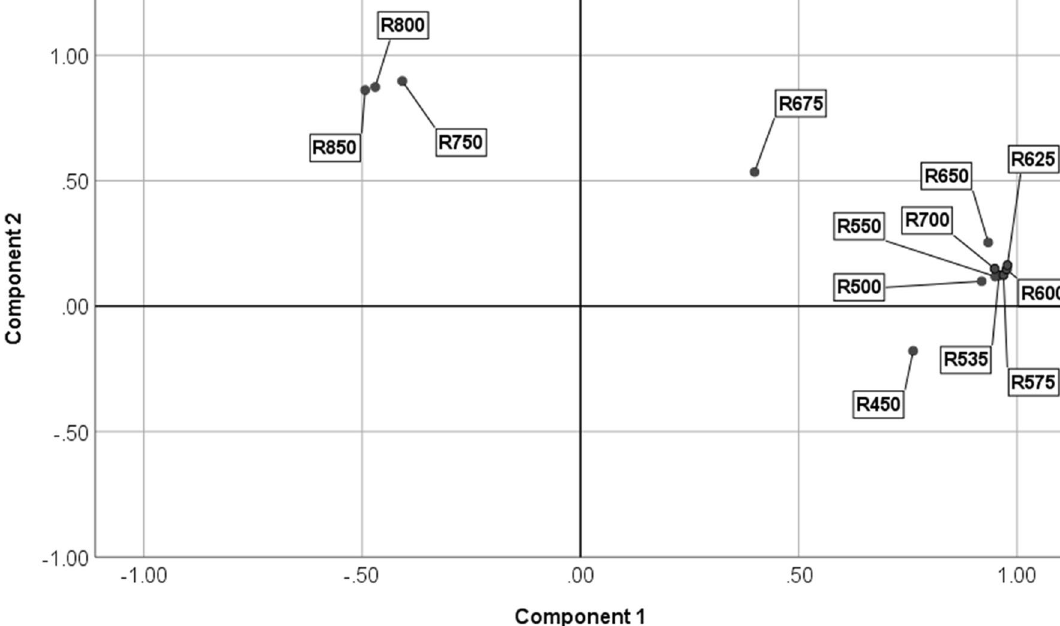
Figure 5. Variable correlation plot for the first two principal components extracted by PCA. Variables are reflectance at the selected thirteen wavelengths. R450 through R850 represent the reflectance measurements at 450 through 850 nm wavelengths.